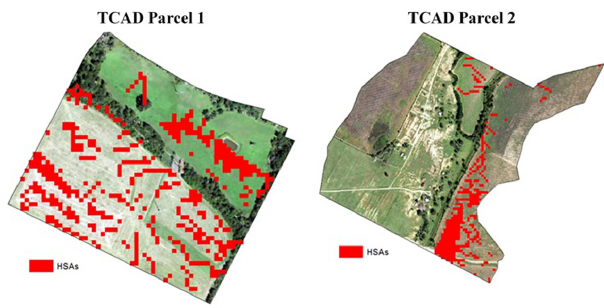
Figure 5. TCAD parcels in Elm Creek watershed. TCAD